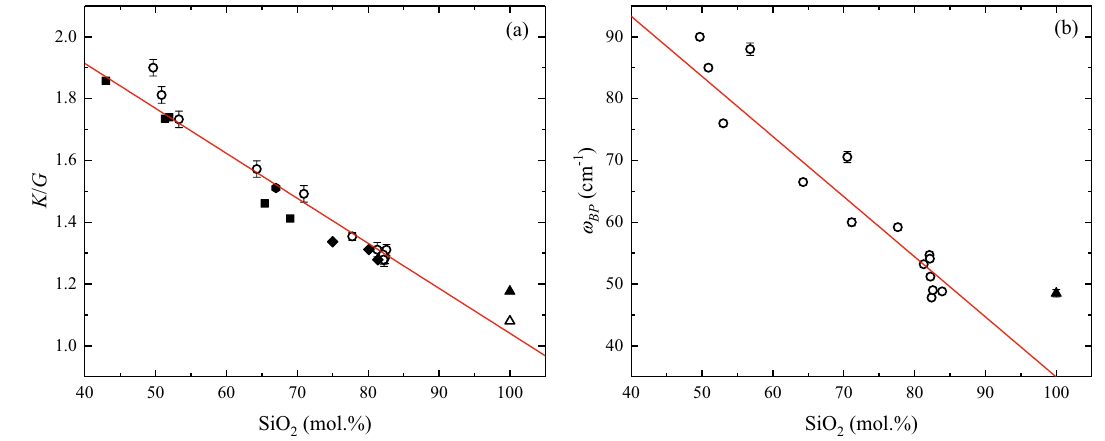
Figure 1. Spectroscopic parameters as a function of SiO 2 content (mol%) of glass. Brillouin ( a ) and Raman ( b ) data of samples (Table 2) from this study (empty circles) and the literature (solid symbols) as a function the SiO 2 (mol%) content of the glasses. The ratio of the bulk ( K ) and shear ( G ) elastic moduli is calculated (Eq. 3) from the Brillouin velocities (Table 2), whereas the boson peak position ω BP is retrieved by fitting the low-frequency Raman spectra of the glasses using a log–normal function (see “Materials, literature data and methods” for details). Red lines in ( a ) and ( b ) are linear fits of the data with Eqs. (4, 5), respectively. Literature data in ( a ) are: (squares) Whittington et al. 35 , (hexagon) Richet and Polian 40 , (diamonds) Hushur et al. 41 , (filled triangle) Zanatta et al. 39 , (unfilled triangle) Novikov et al. 36 . Literature datum in ( b ) is from Zanatta et al. 39